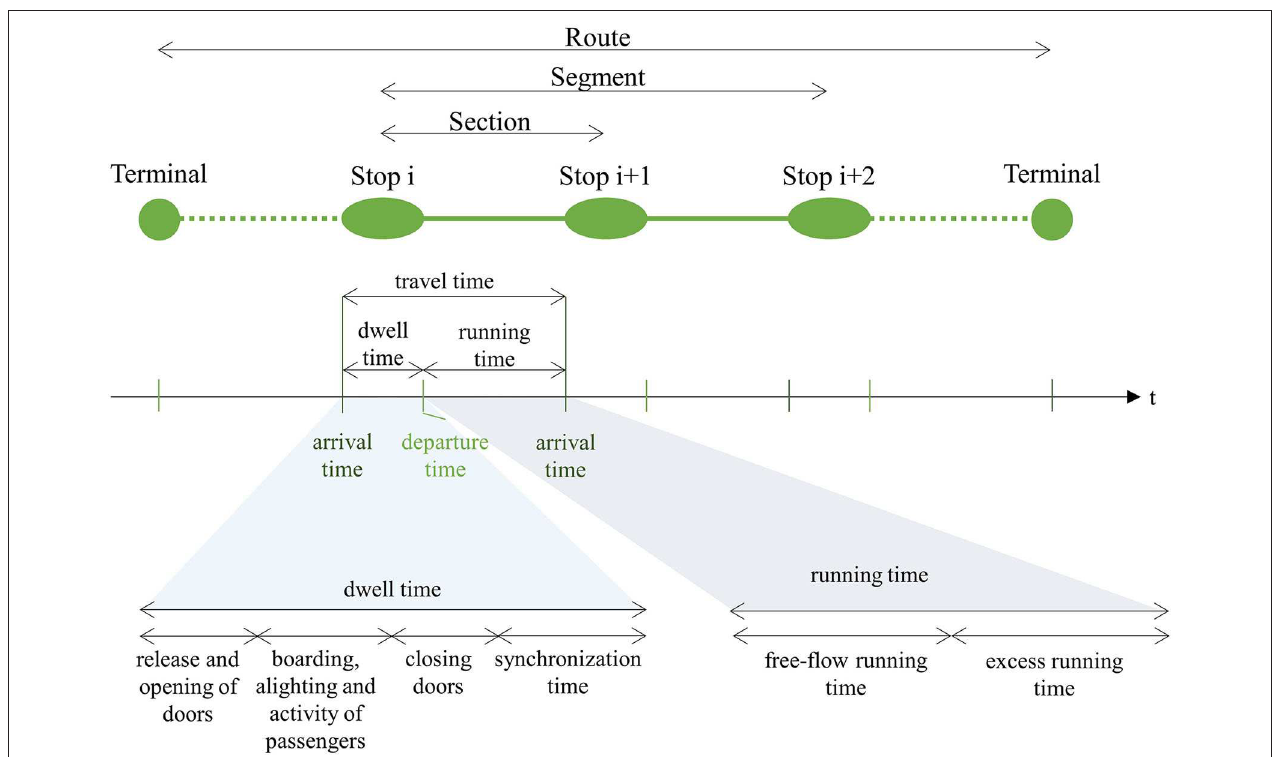
FIGURE 2 | Spatial definitions of a bus line, and components of travel, dwell, and running